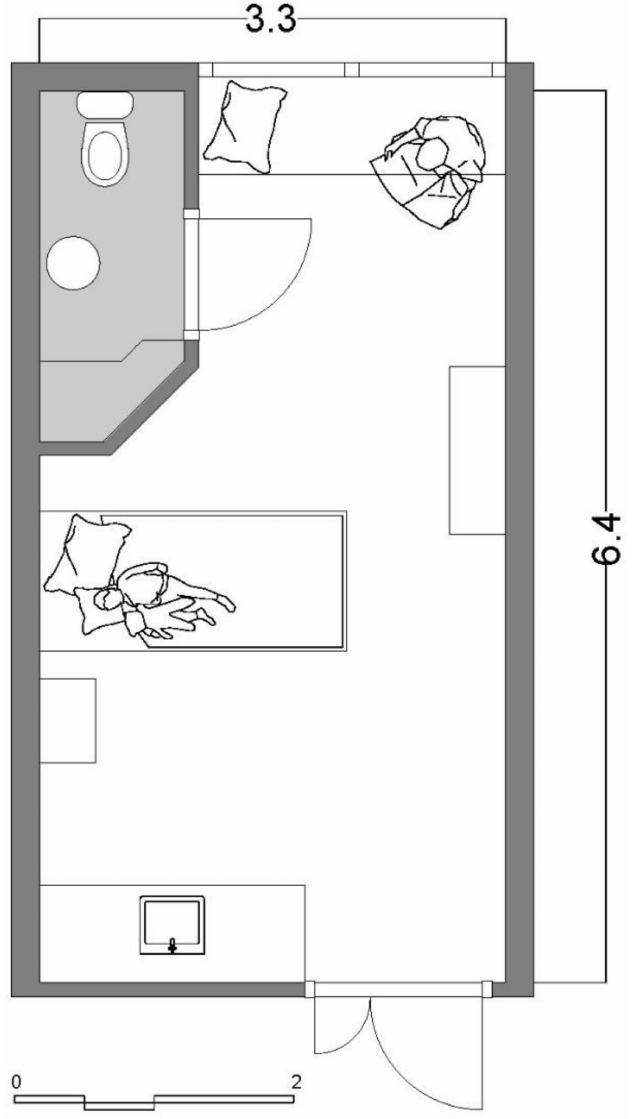
Figure 1. Average patient room typology of the observed hospitals. Net m 2 : 18.8 m 2 patient room and 2.4 m 2